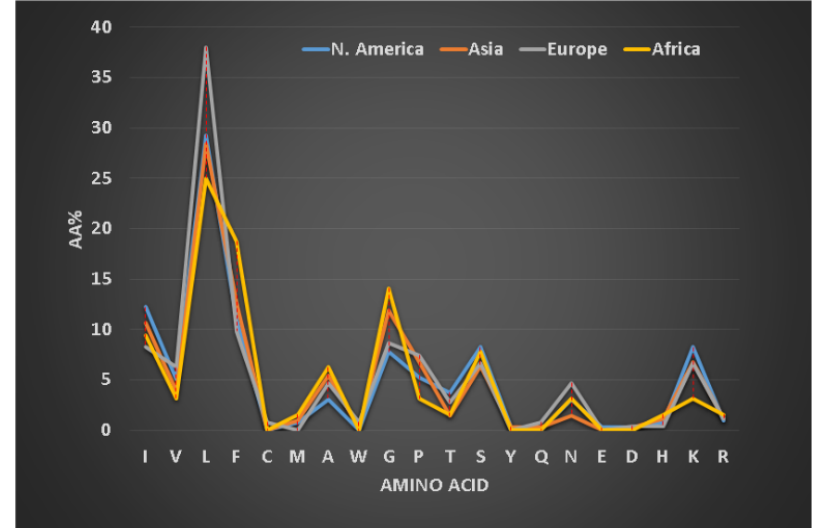
Figure 4. Variation in the amino acid signatures of temporins discovered in four regions: 5 from Africa, 66 from Asia, 20 from Europe and 30 from North America. The dotted vertical line indicates the maximal difference between two groups. Data from the APD as of June 2020 [78].